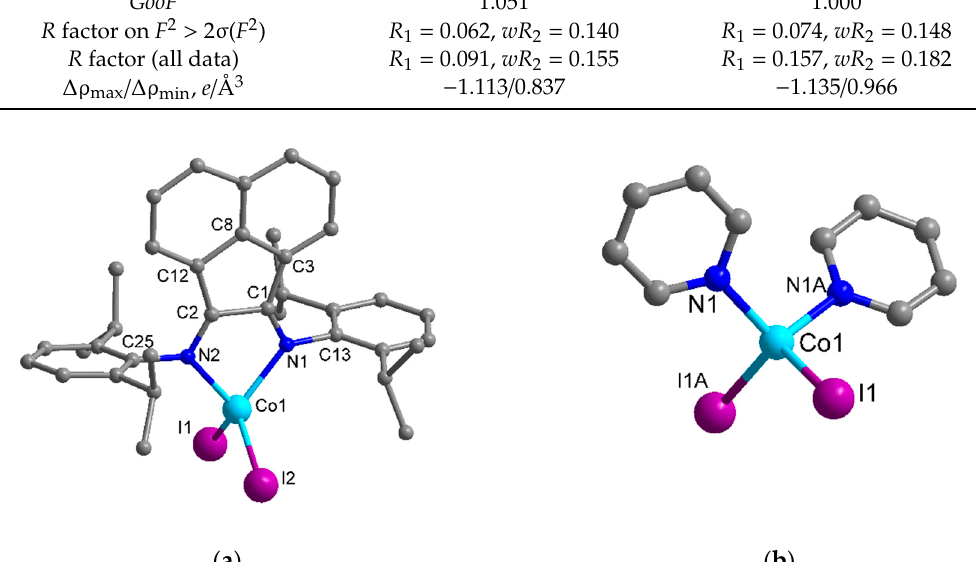
Figure 1. Molecular structure of complexes I ( a ) and II ( b ). Hydrogen atoms are omitted. Symmetry codes used to generate equivalent atoms for II: (A) − x + 1, y, − z + 1 / 2. The C − C and C − N bond lengths in the α -diimine fragment of complex I (C(1) − C(2) 1.515(5) Table 1. Crystallographic data, details of the data collection, and characteristics of the data refinement for I and II.